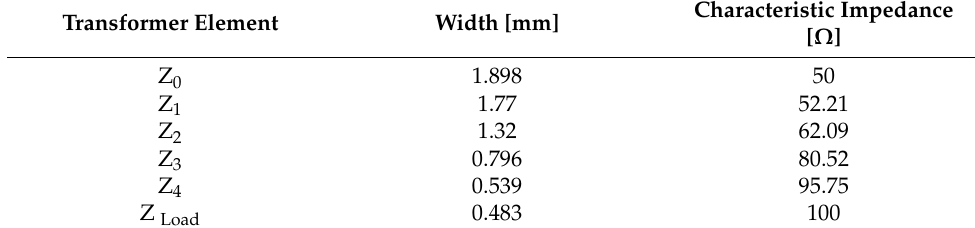
Table 1. Width and characteristic impedance of the transformers. Transformer Element